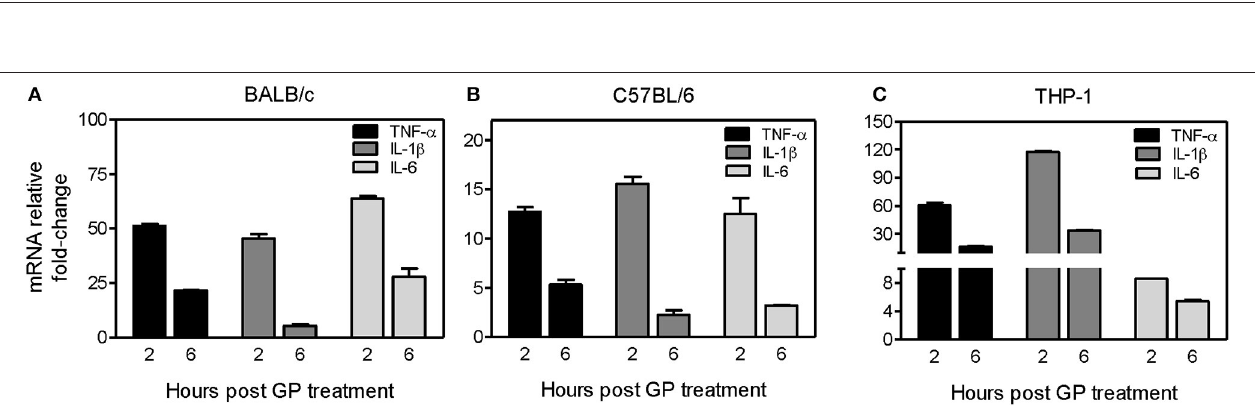
FIGURE 3 | EBOV GP induces gene expression of pro-inflammatory cytokines in mouse and human immune cells. BMDMs prepared from (A) BALB/c mice, (B) C57BL/6 mice, or (C) human THP-1 cells were treated with 1 µ g/mL EBOV GP, and total cellular RNA was extracted. The change in the mRNA levels of TNF- α , IL-1 β , and IL-6 at 2 and 6 h after treatment was analyzed by qRT-PCR using specific primers. The data was normalized to GAPDH mRNA and fold-change was calculated as described previously. The results are presented as mean ± SEM of at least two independent treatments analyzed in duplicate wells.